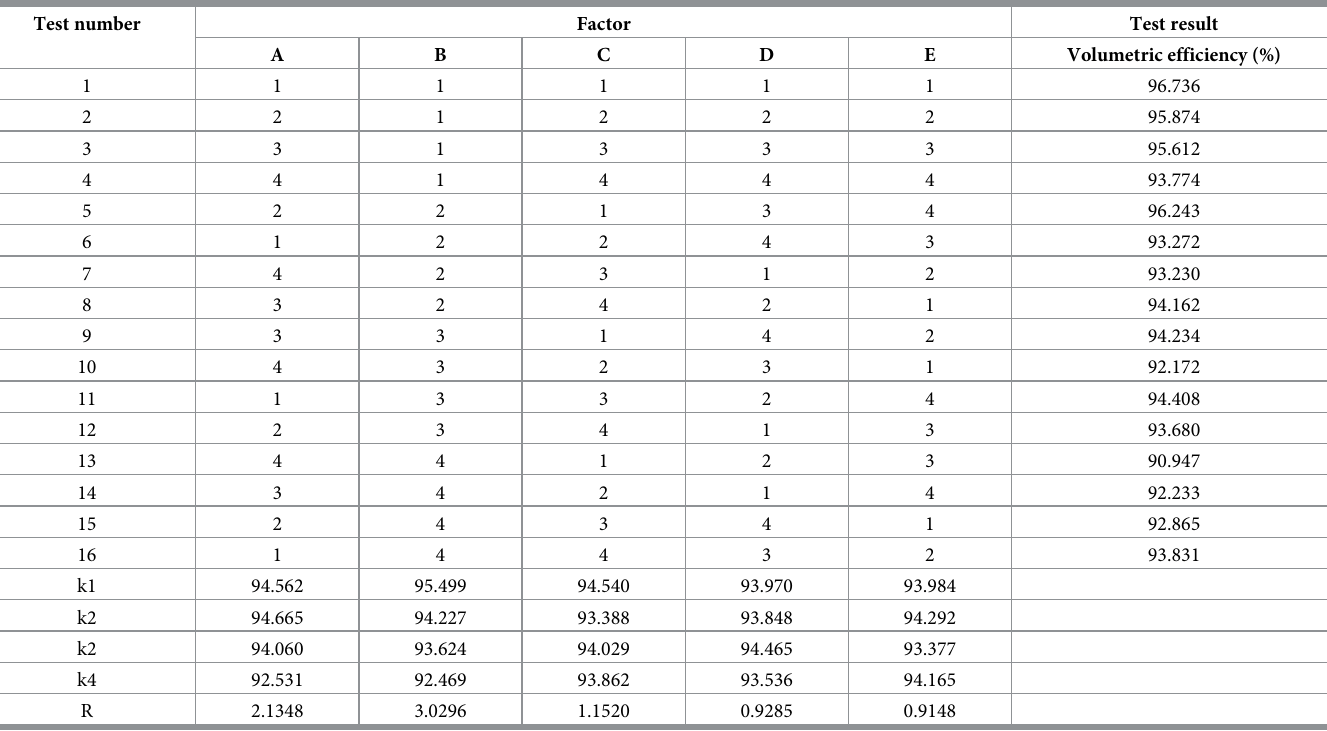
Table 11. Orthogonal test analysis table of volumetric efficiency.